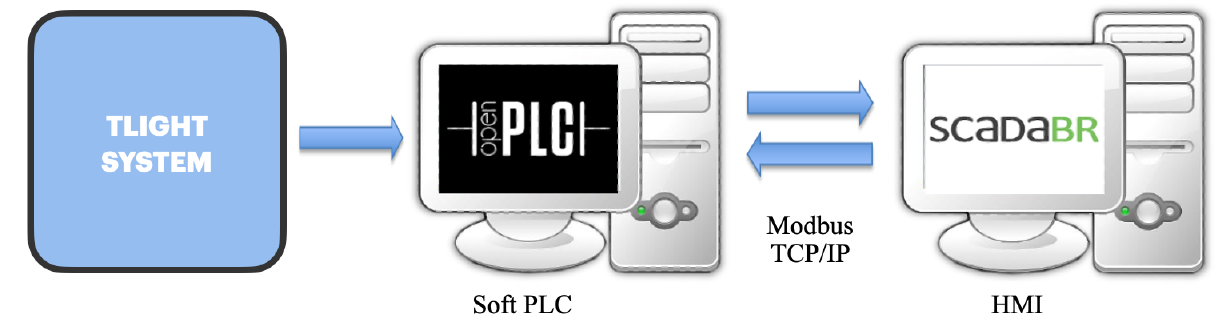
Figure 3. Diagram of the cyber-physical system network interconnection and information